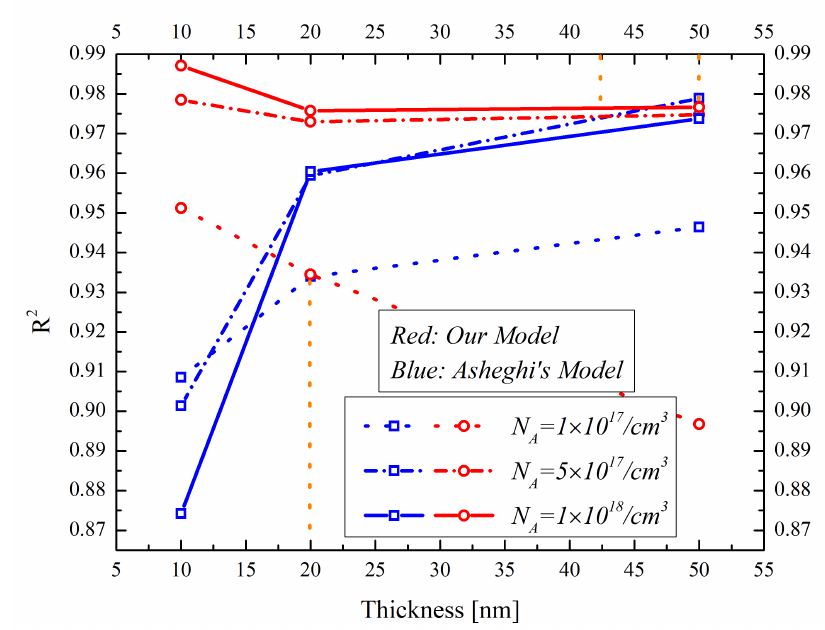
Figure 7. The coefficients of determination in the nonlinear regression analysis of the thermal conductivity models with different doping concentration discussed in this paper.